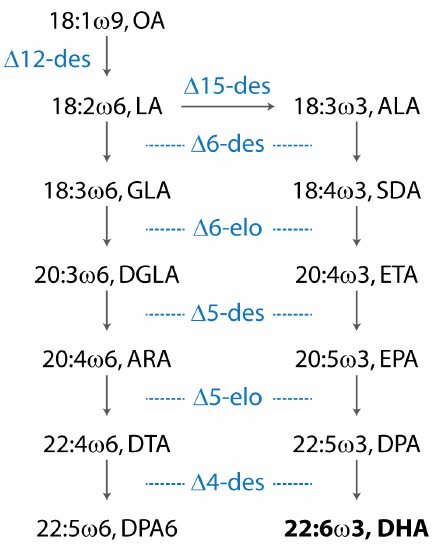
Figure 1. The parallel v 6 and v 3 D 6-desaturase pathway for DHA synthesis described in this article. ‘Des’ denotes desaturase and ‘elo’ denotes elongase. OA, oleic acid; LA, linoleic acid; GLA, c - linolenic acid; DGLA, dihomo- c -linolenic acid; ARA, arachidonic acid; DTA, docosatetraenoic acid; DPA6, v 6 docosapentaenoic acid; ALA, a - linolenic acid; SDA, stearidonic acid; ETA, eicosatetraenoic acid; EPA,